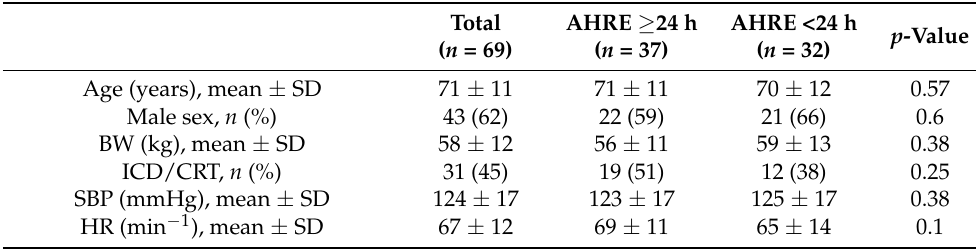
Table 2. Comparison of demographics between patients with AHRE ≥ 24 h and <24 h in patients with a history of